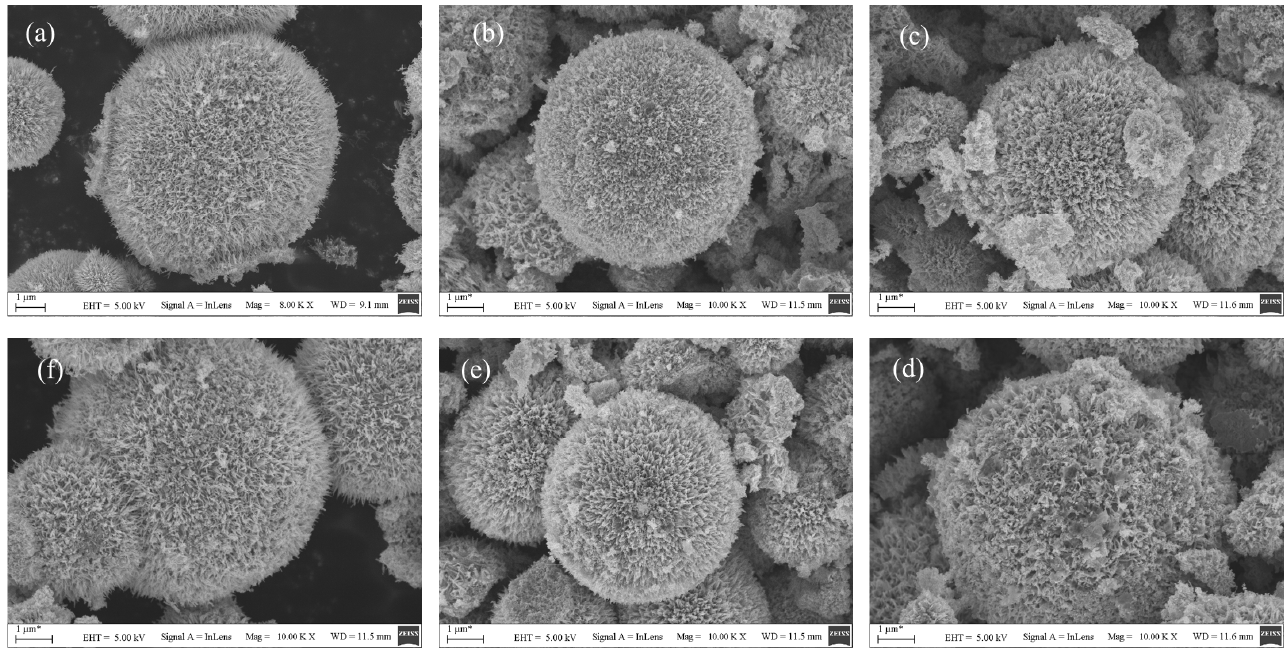
Figure 2. Scanning electron microscopy (SEM) images of NCO ( a ) and the modified NCO which were etched using the solution of NaBH 4 or Na 2 SO 3 etching: NCO-RB 10 (10 mmol/L NaBH 4 ) ( b ), NCO-RB 15 (15 mmol/L NaBH 4 ) ( c ), NCO-RB 20 (20 mmol/L NaBH 4 ) ( d ), NCO-RB 25 (25 mmol/L NaBH 4 ) ( e ), and NCO-RS 20 (20 mmol/L Na 2 SO 3 ) ( f ).